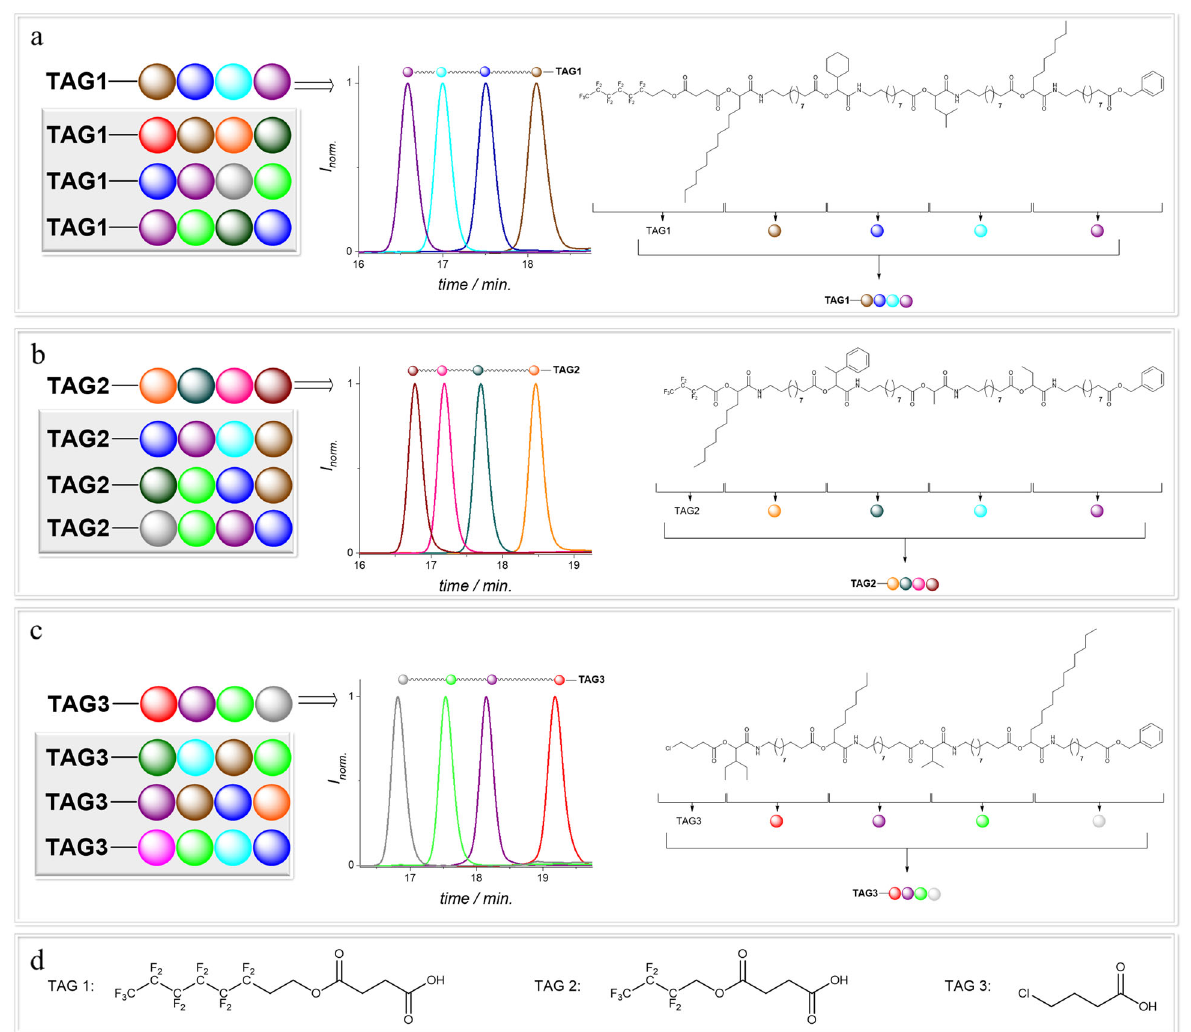
Fig. 2 Schematic representation of the variation of the twelve different aldehydes (colored bullets) and SEC traces of three different tetramers, one for each tag. a Chemical structure and SEC traces of a tetramer with TAG1 and the sidechain variation of the aldehydes 14a – l (see Supplementary Methods for detailed information) for another three tetramers. b Chemical structure and SEC traces of a tetramer with TAG2 and the sidechain variation of the aldehydes 14a – l (see Supplementary Methods for detailed information) for another three tetramers. c Chemical structure and SEC traces of a tetramer with TAG3 and the sidechain variation of the aldehydes 14a – l (see Supplementary Methods for detailed information) for another three tetramers. d Chemical structures of TAG1 –